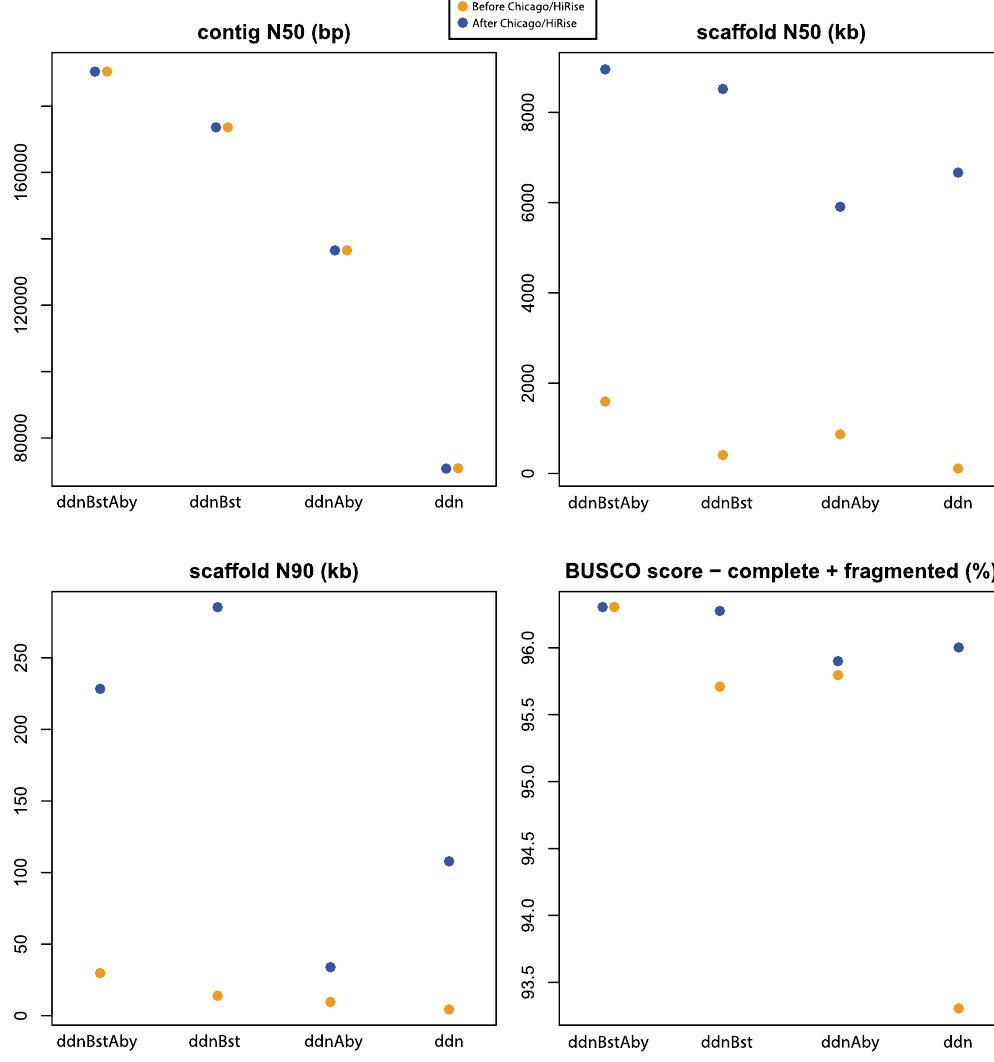
Figure 3. Comparison of four contiguity and accuracy statistics among the eight candidate assemblies described in Fig. 2. Contig N50, scaffold N50, scaffold N90 and the proportion of at least partial (complete and fragmented) genes present in our assembly of a set of 3,023 highly conserved single-copy orthologs (BUSCO score), considering fragments longer than 500